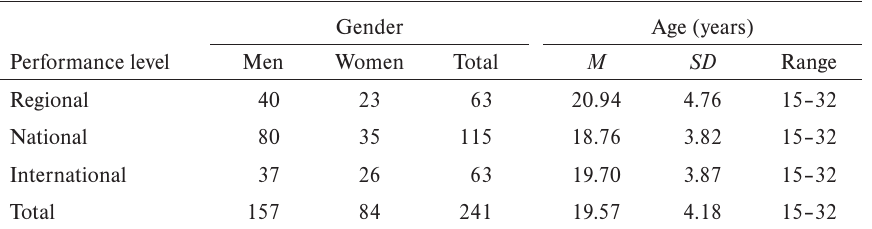
Basic characteristics of the research